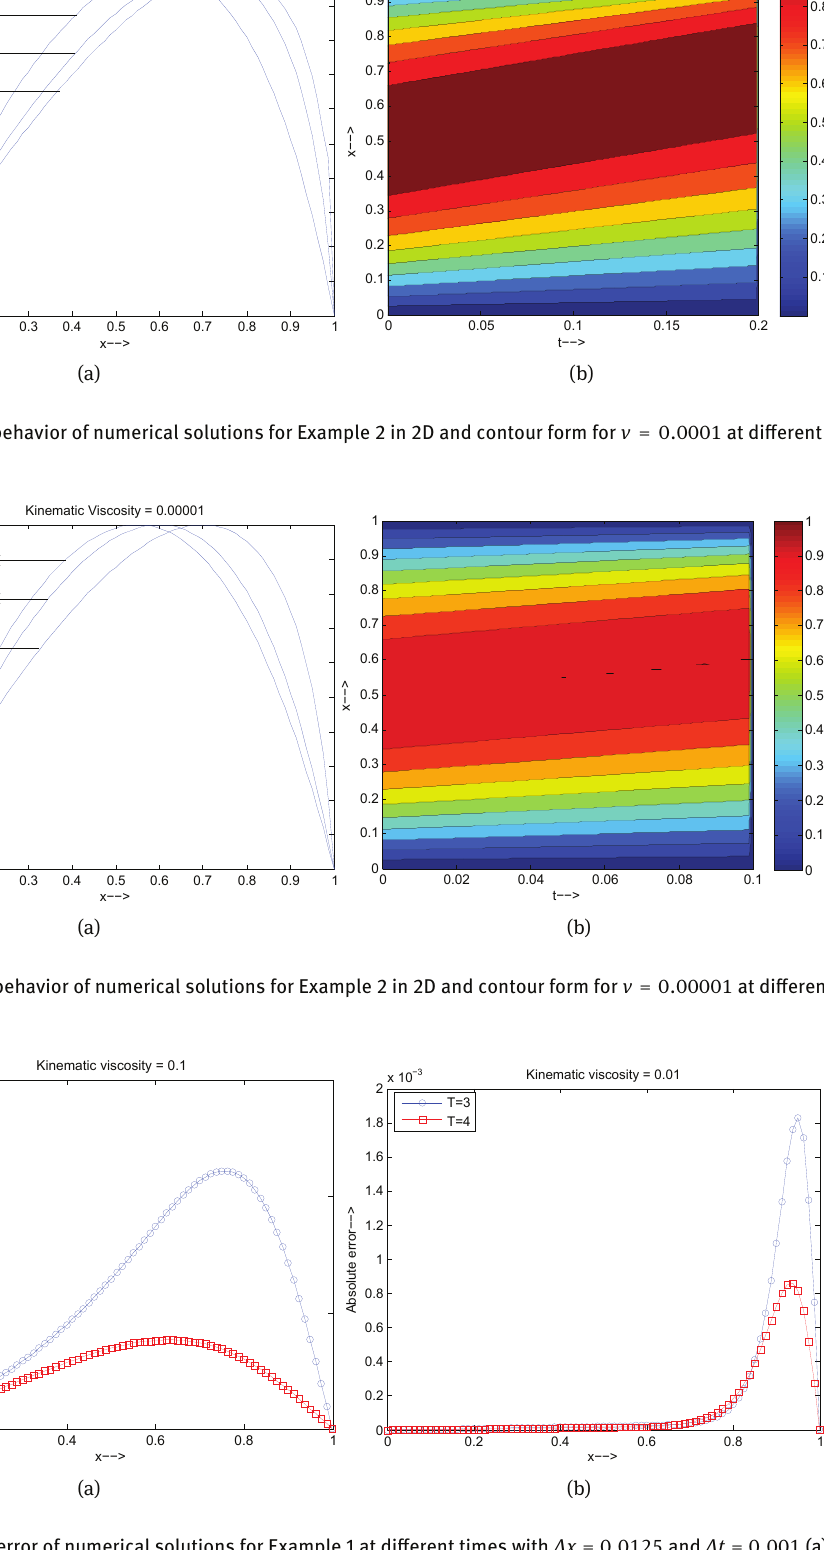
Fig. 17: Absolute error of numerical solutions for Example 1 at different times with Δx = 0.0125 and Δt = 0.001 (a) ν = 0.1 (b) ν = 0.01